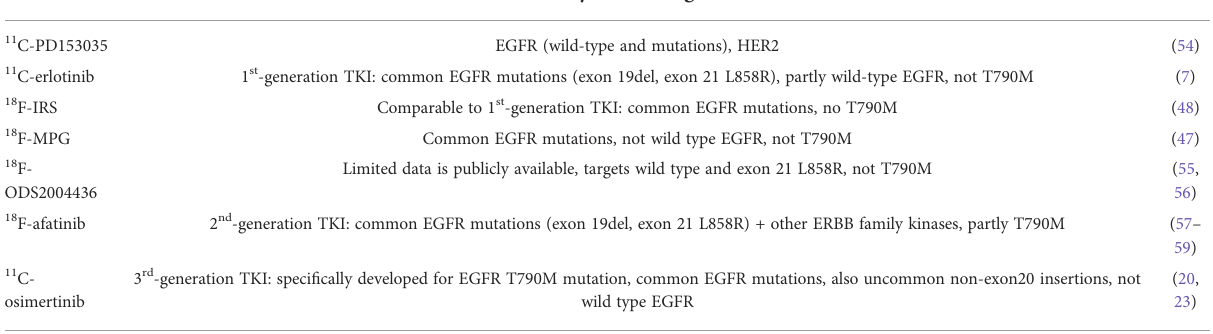
TABLE 2 Key tracer targets for each tracer are shown.